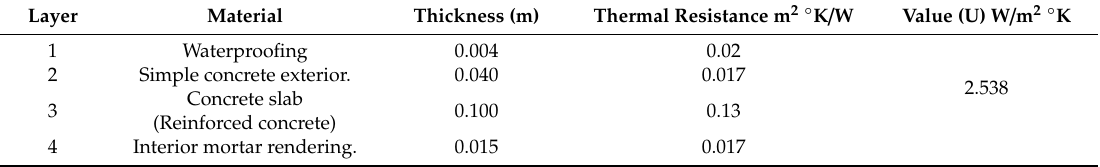
Table 3. Elements of the roof in a typical construction in the Dominican Republic.